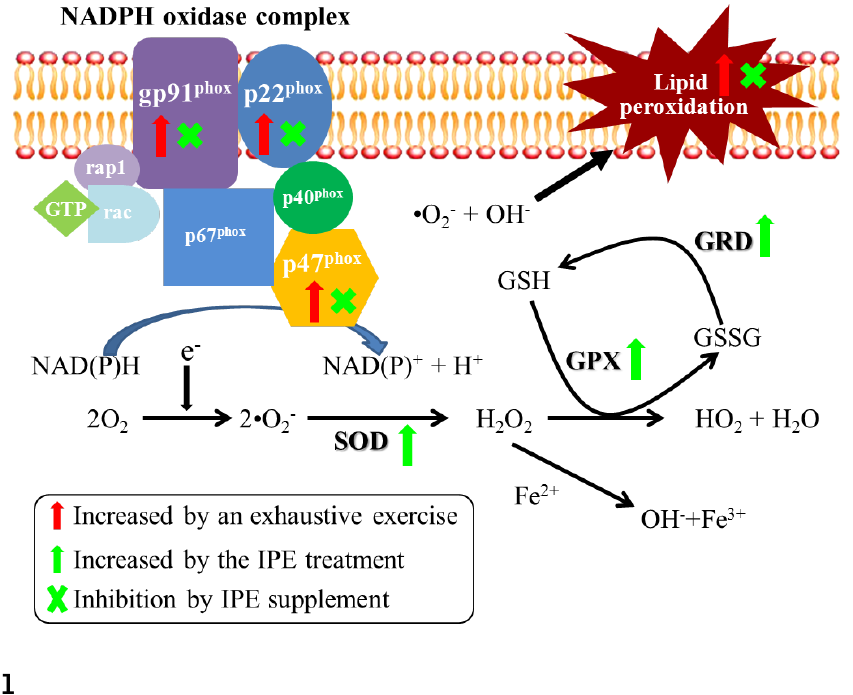
Figure 6. Summary of proposed mechanisms of I. parviflora extract (IPE) supplementation that served to protect mice from a single bout of exhaustive exercise-induced oxidative stress. The red (  ) and green arrows (  ) represent upregulation by exhaustive exercise challenge and IPE treatment, respectively. The (  ) symbol represents inhibition by IPE